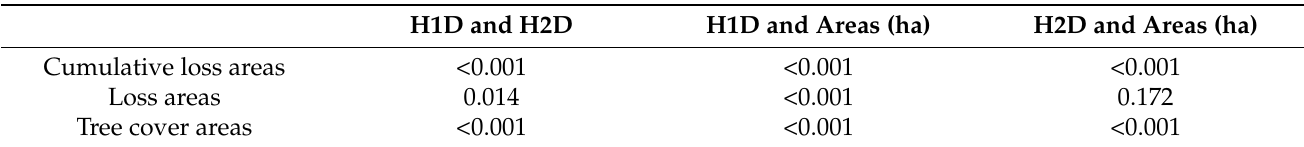
Table 4. Significances of slope for linear regressions between Higuchi dimensions 1D and 2D and between Higuchi dimensions and corresponding areas.